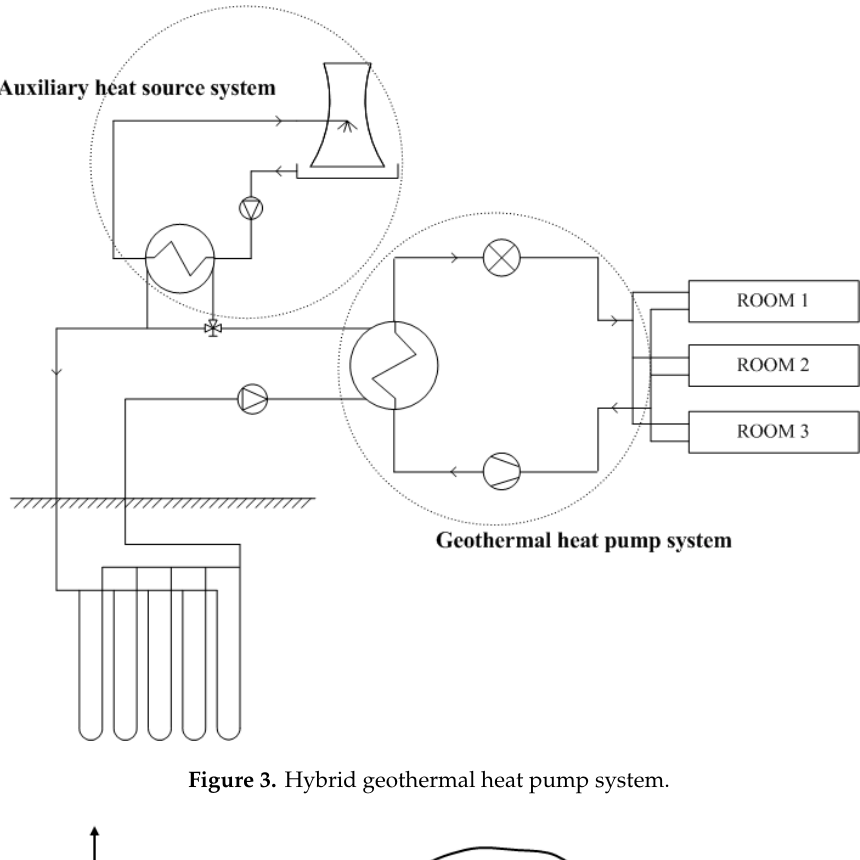
Figure 3. Hybrid geothermal heat pump system.